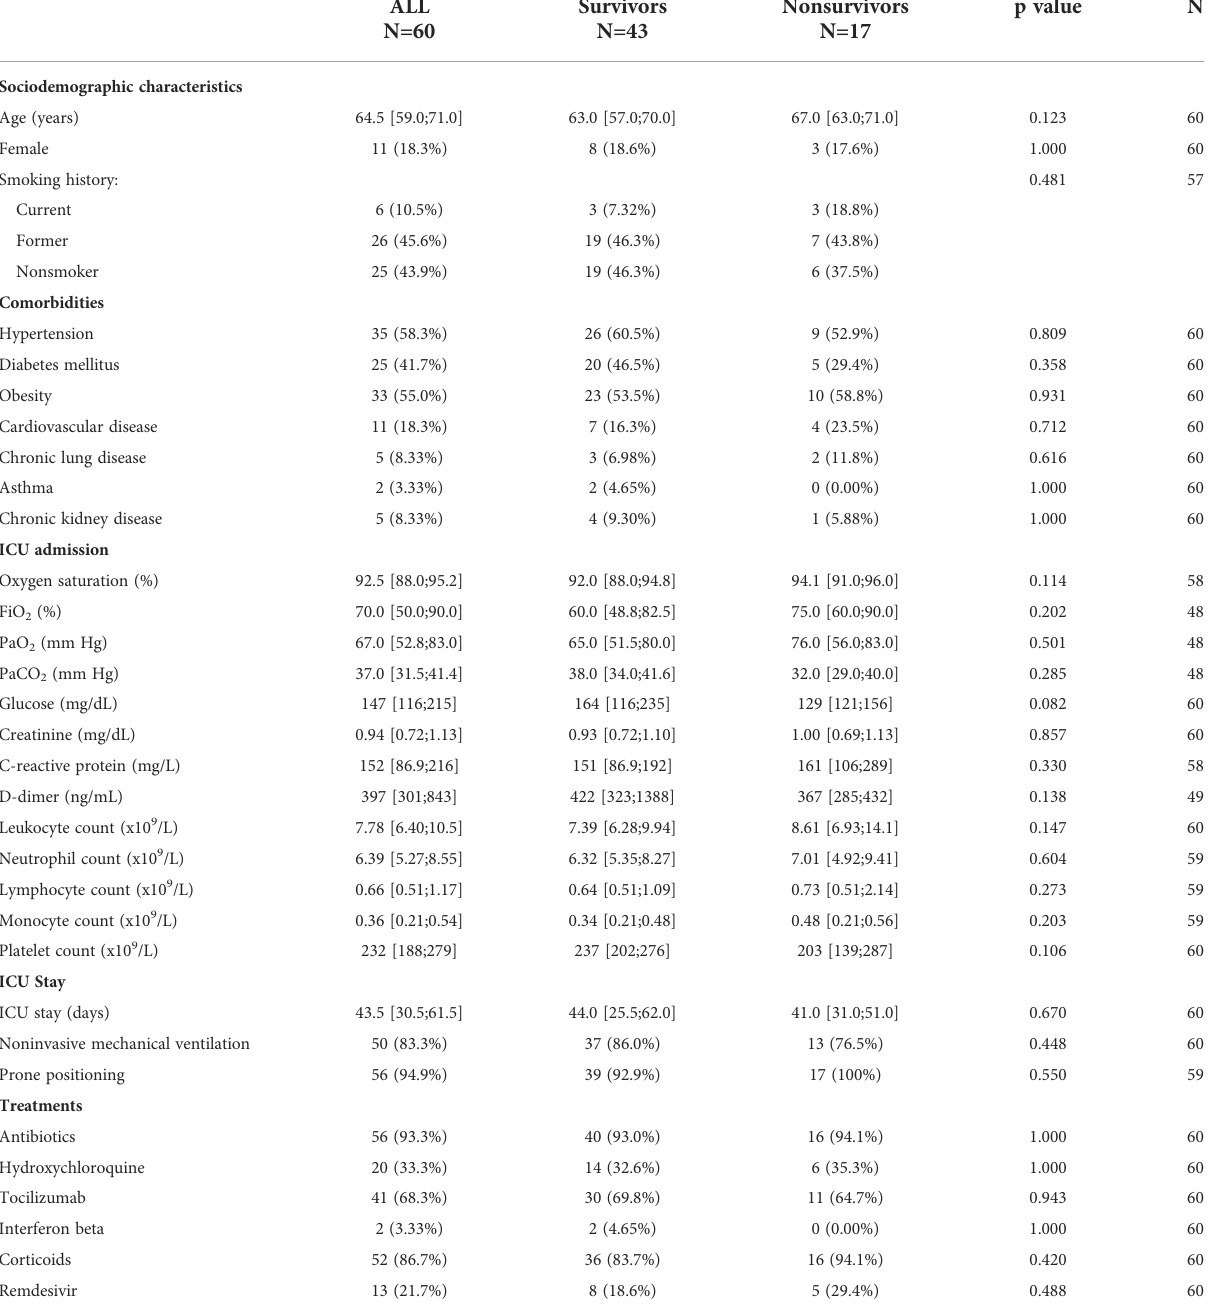
TABLE 2 Characteristics of ICU COVID-19 survivors and nonsurvivors ARDS secondary to SARS-CoV-2 infection (study population 2). ALL